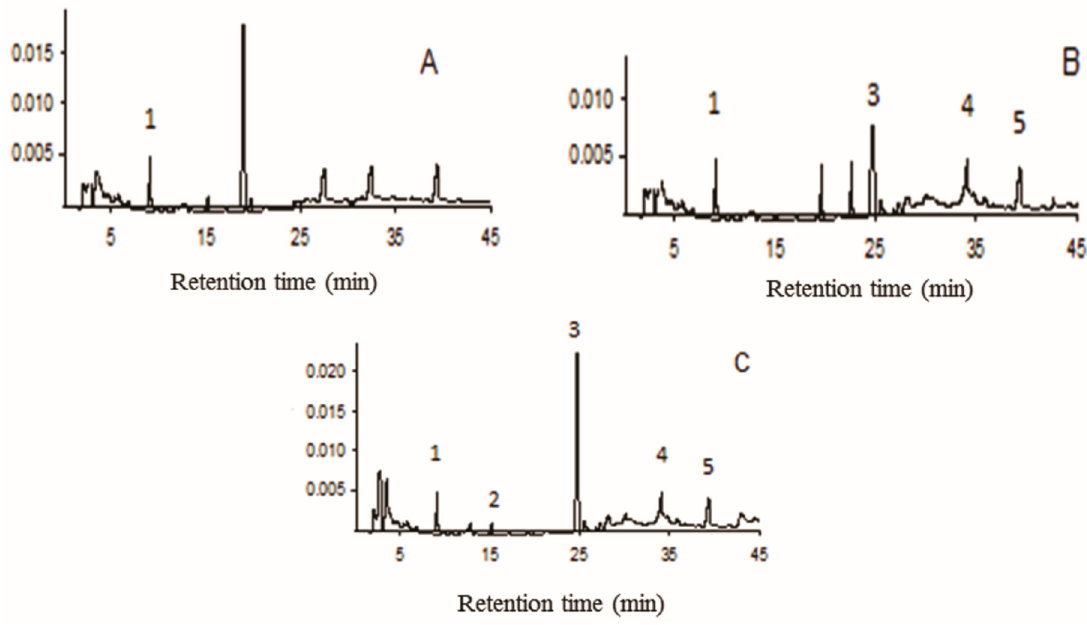
Table 3. Compounds identified and quantified by HPLC analysis.